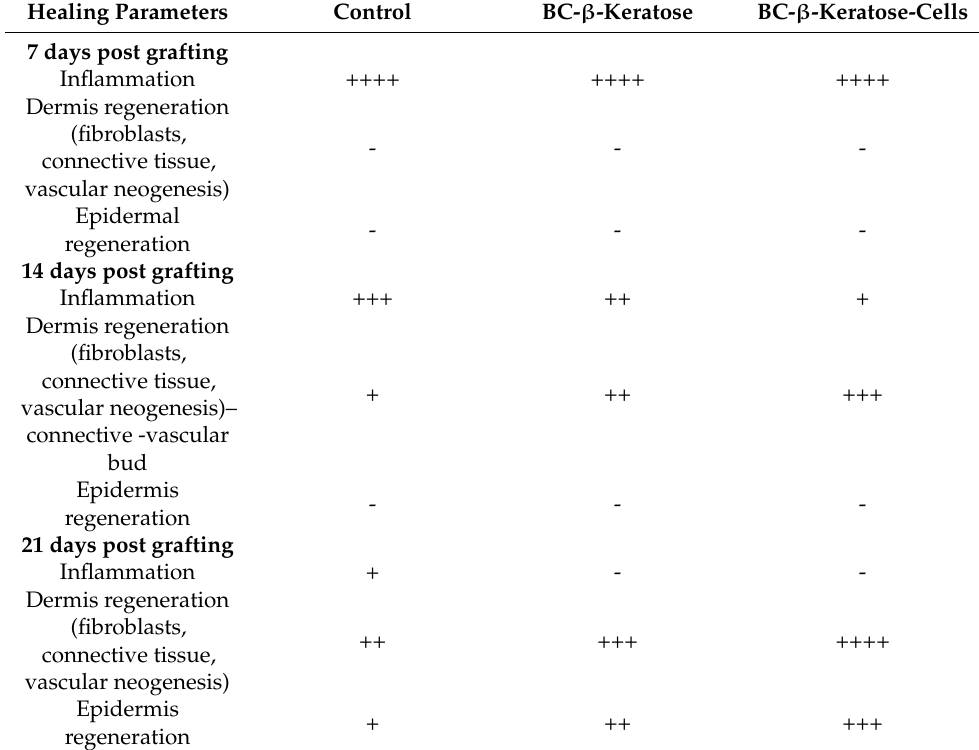
Table 3. Anatomic–pathological